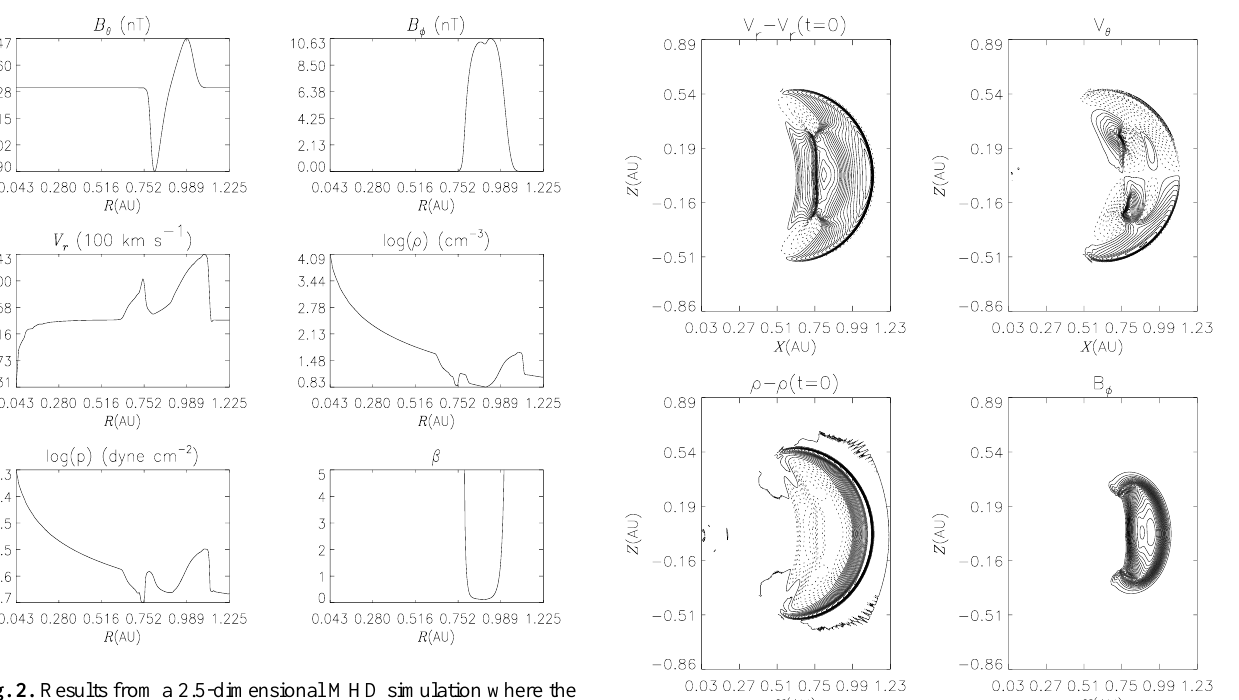
Fig. 2. Results from a 2.5-dimensional MHD simulation where the initial ICME velocity is double that of the solar wind. The six plots are cuts through the ICME along θ = 0, and the panels show B θ , B φ , V r , the density, pressure and plasma beta 2.57 days after the initiation.